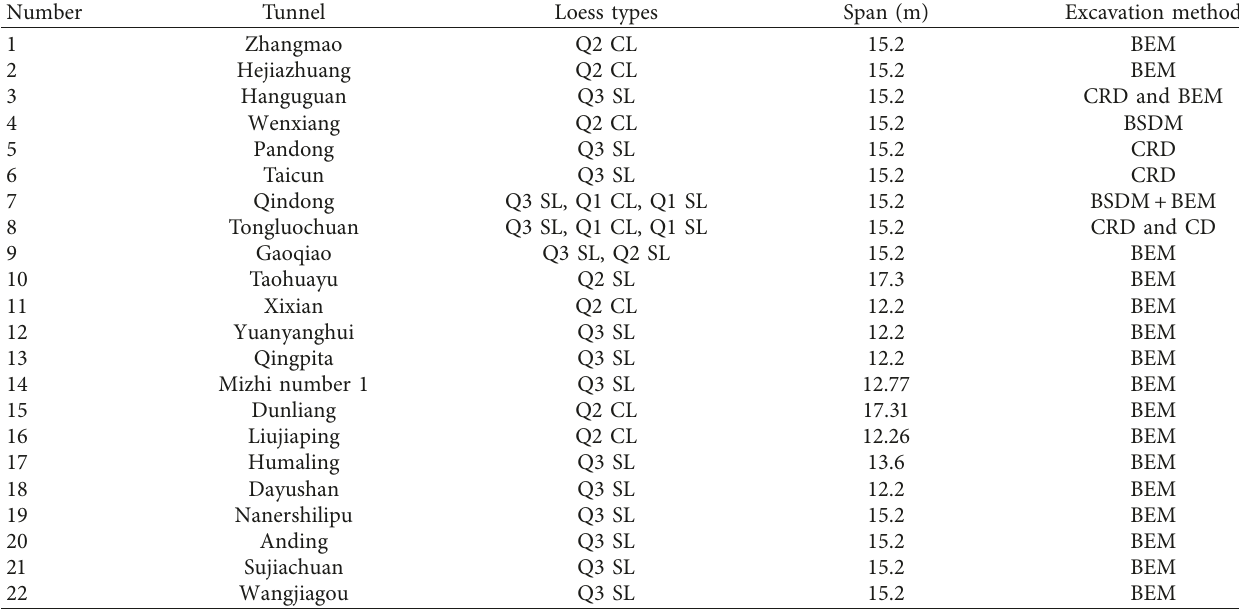
Table 1: Overview of part loess tunnels [26, 36,